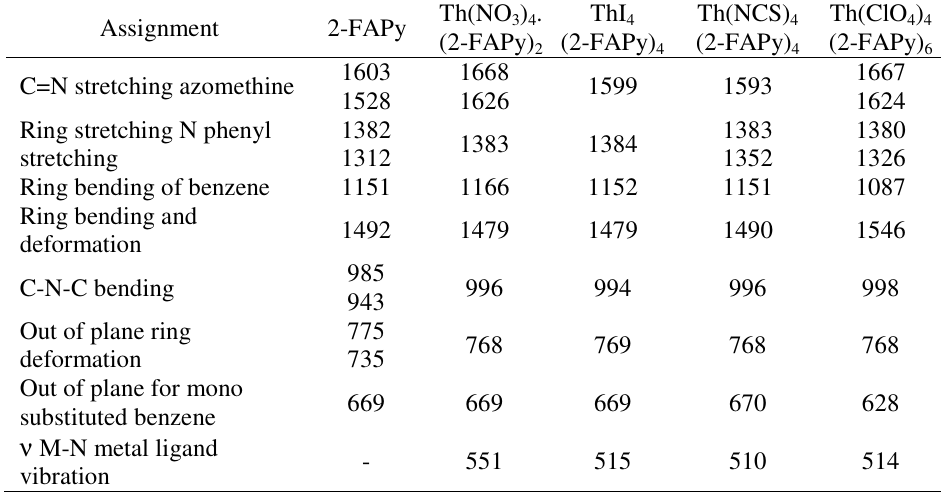
Table 2. Infra red absorpton frequencies (cm -1 ) for thorium(IV) complexes of